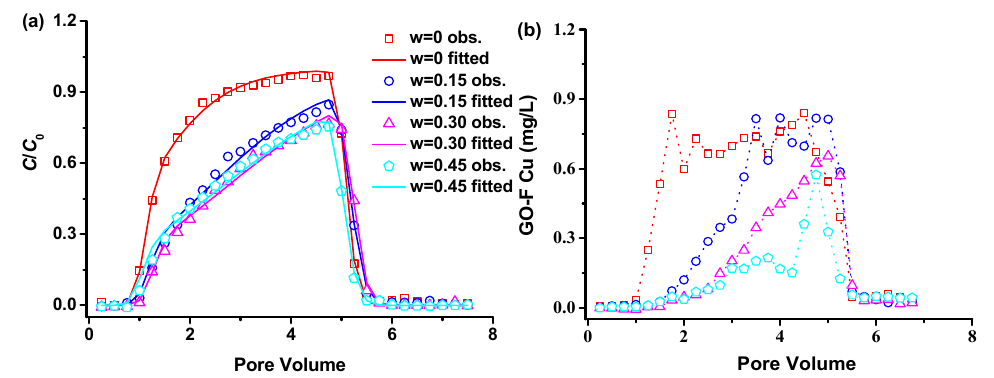
Figure 4. Observed (dots) and simulated (solid lines) transport of Cu ‐ loaded GO ( a ) and observed (dots connected using dash lines) GO ‐ facilitated Cu ( b ) under different Fe oxide fractions ( ω = 0 ‒ 0.45) at pH = 5.0 and IS = 1.0 mM KCl. Symbols are experimental data and solid lines are the fitted results obtained from the two ‐ site kinetic attachment model, as shown in ( a ).